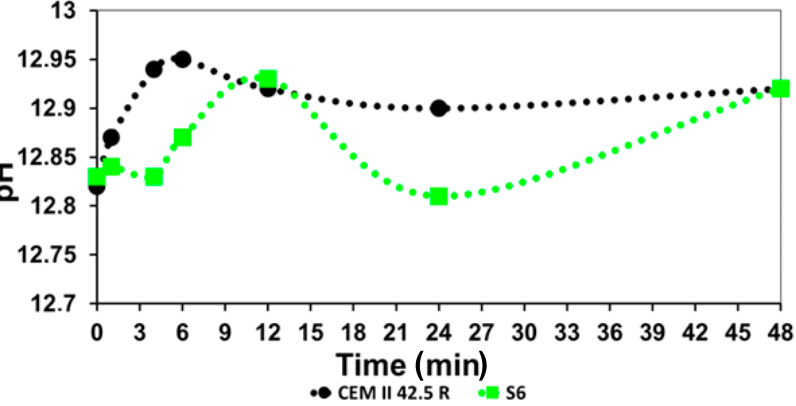
Figure 7. Evolution of the pH value during the outgoing process of hydration of cement (grey) and of the cement doped with the sample S6 (green) (Table 1).